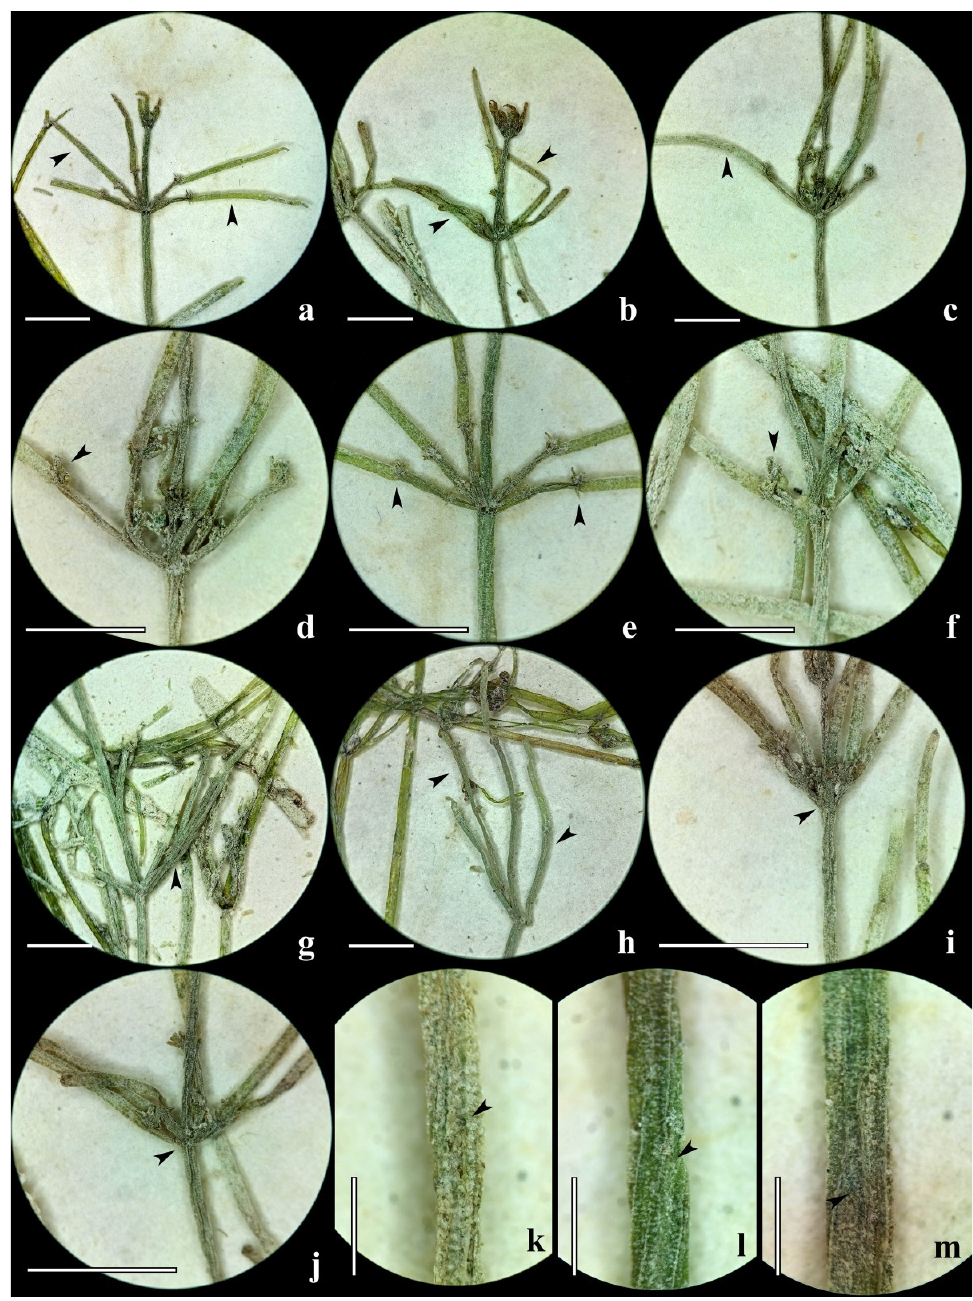
Figure 3. Lectotype of Chara dissoluta (LE A0001500): ( a , b )—lax apical parts showing long ecorticate undifferentiated segments of branchlets (arrowheads); ( c )—base of branchlet whorl, arrowhead indicates long ecorticate undifferentiated segment of branchlet; ( d – f )—bases of branchlet whorls showing short corticated basal segments, short bracts and conjoined gametangia (arrowheads); ( g , h )—bases of branchlet whorls showing long corticated basal segments (arrowheads); ( i , j )—bases of branchlet whorls showing short hardly recognizable stipulodes (arrowheads); ( k – m )—stem cortex, arrowheads indicate short barely visible spine cells ( k ) or empty spaces between primary cortical tubes ( l , m ). Scale: ( a – j )—5 mm, ( k – m )—1 mm. Photos by R.E. Romanov.